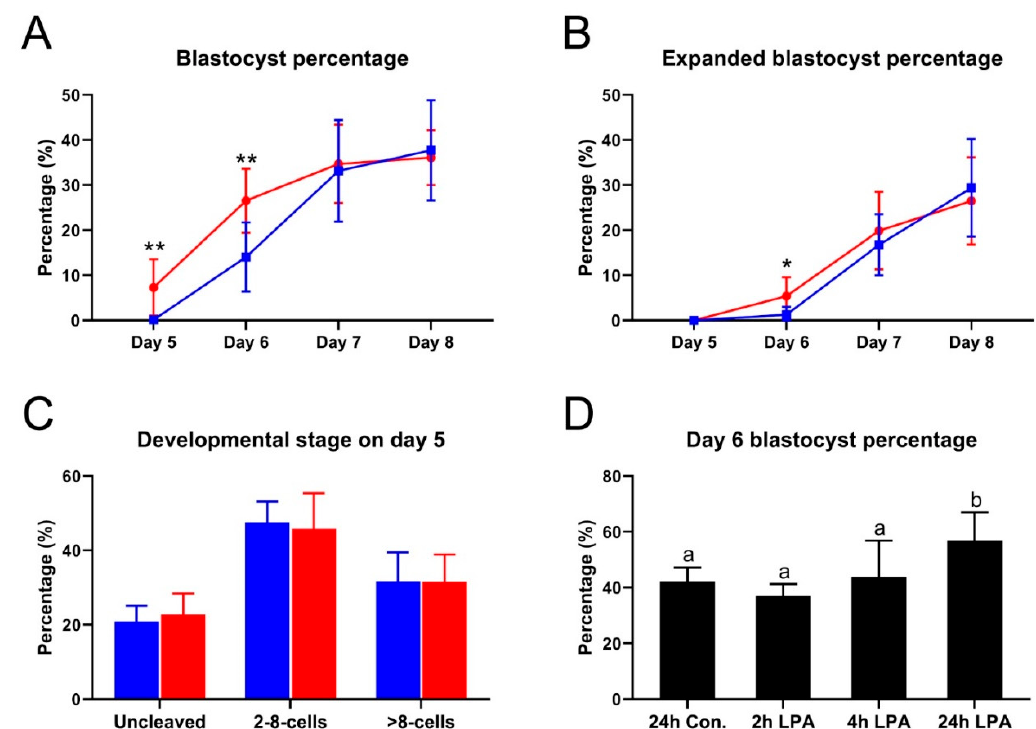
Figure 1. Effect of lysophosphatidic acid (LPA) on bovine embryo development. Blastocyst percentage ( A ) and expanded blastocyst percentage ( B ) after in vitro culture in the absence (blue) or presence (red) of 10 − 5 M LPA. Significant differences are individual time points are indicated by * ( p < 0.05) and ** ( p < 0.01). ( C ) Embryo development at day 5 after culture without (blue) and with (red) LPA. ( D ) Blastocyst percentage on day 6. Embryos with >8 cells were collected on day 5 and cultured without LPA (control) and with LPA for different time periods as indicated, and further cultured without LPA to complete the 24 h. Significant differences among columns are indicated by different letters above the bars. Data are depicted as mean ± standard deviation of more than three biological replicates. Con. = control, h = hours.